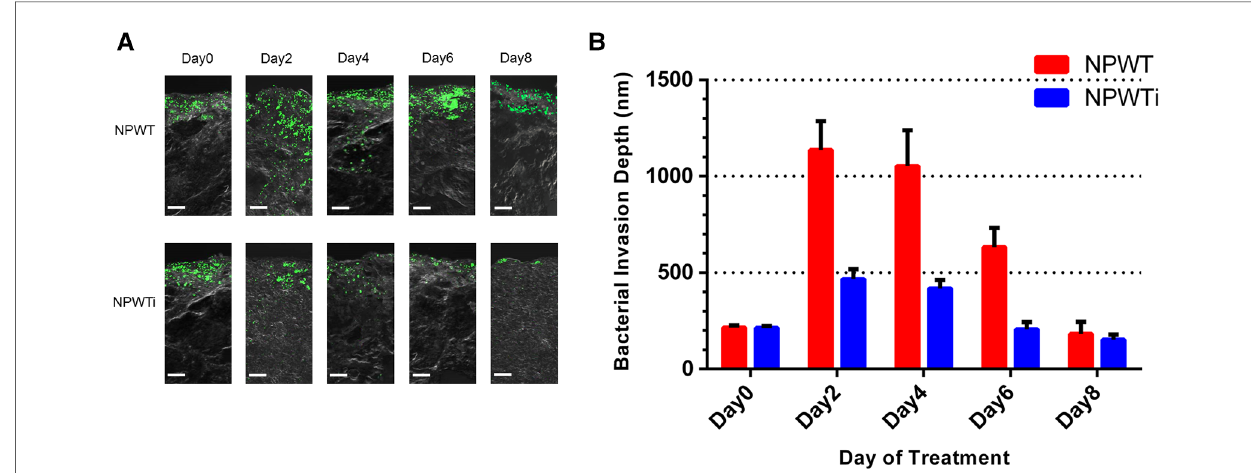
FIGURE 5 Bacterial invasion depth observed by laser scanning confocal microscopy. ( A ) This fi gure shows the depth of infection in NPWT and NPWTi on days 0, 2, 4, 6, and 8. ( B ) Bacterial invasion depth signi fi cantly descended in the NPWTi group compared with the NPWT group at day 2, 4, 6, and day 8 (* P <0.001). Scale bar was 100 um.